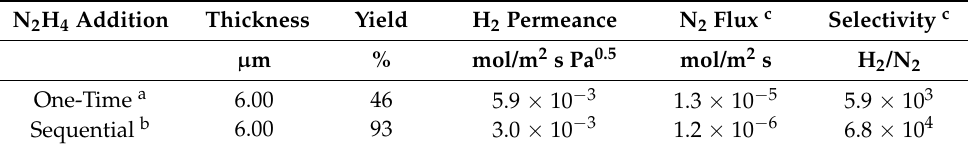
Table 3. Compositions of EDTA-free baths for electroless Pd plating.